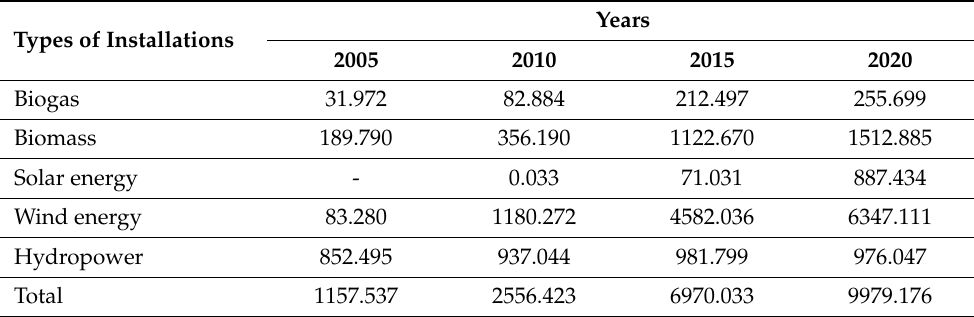
Table 1. Dynamics of installed renewable energy generation capacities within 2005–2020 in Poland [in MW].